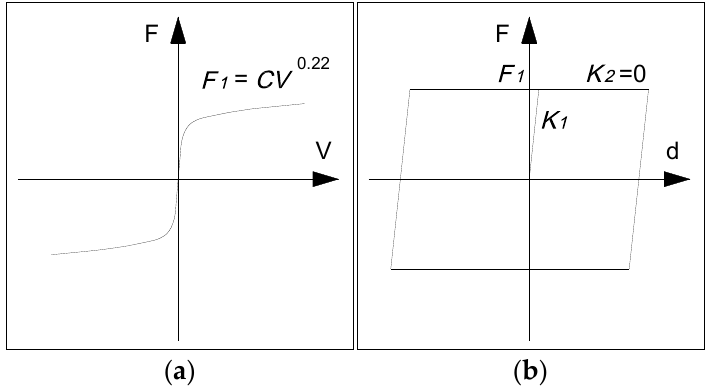
Figure 3. Analytical model of viscous damper. ( a ) Force–velocity. ( b ) Force–displacement.